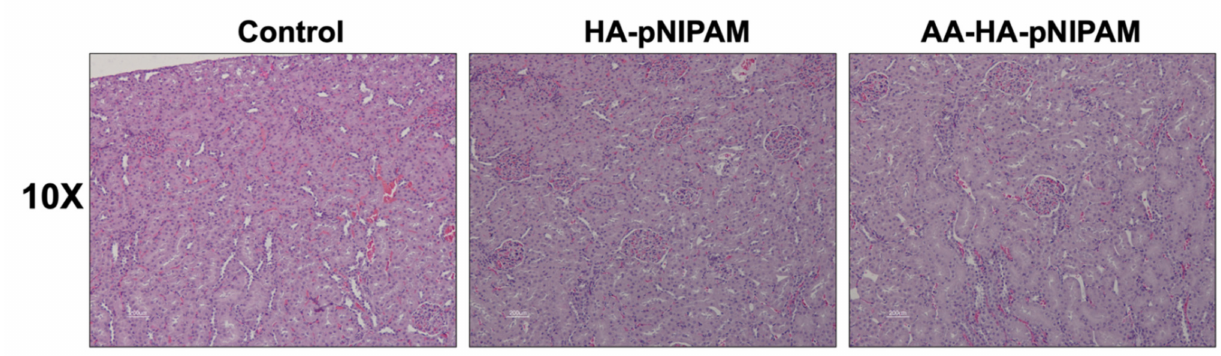
Figure 11. Microscopic images of kidneys from rats treated with UPW, HA-pNIPAM and AA-HA-pNIPAM. Hematoxylin and eosin (H&E) staining; 10 ×